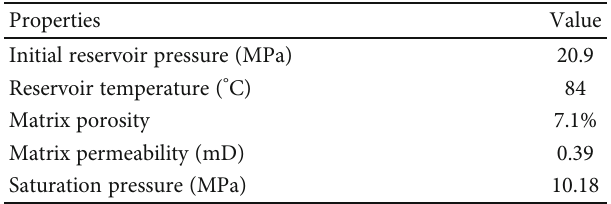
Table 4: Reservoir properties used for the